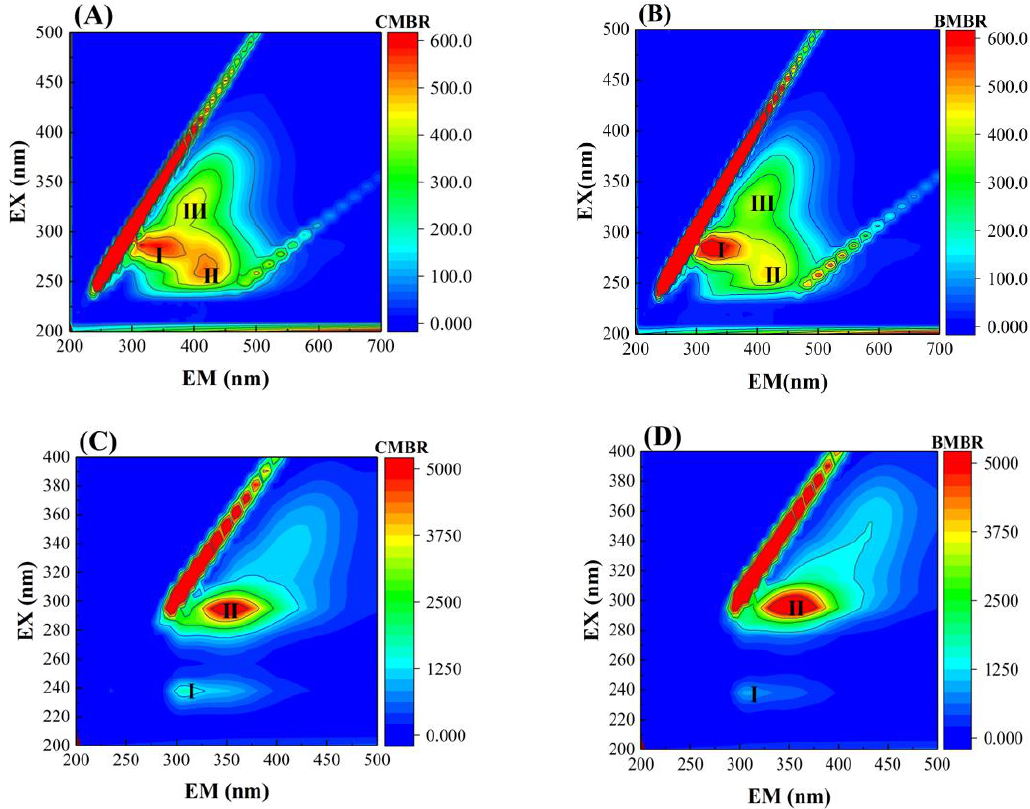
Figure 3. 3D-EEM fluorescence spectra of SMP ( A , B ) and EPS ( C , D ) in the conventional MBR (CMBR) and biochar MBR (BMBR).